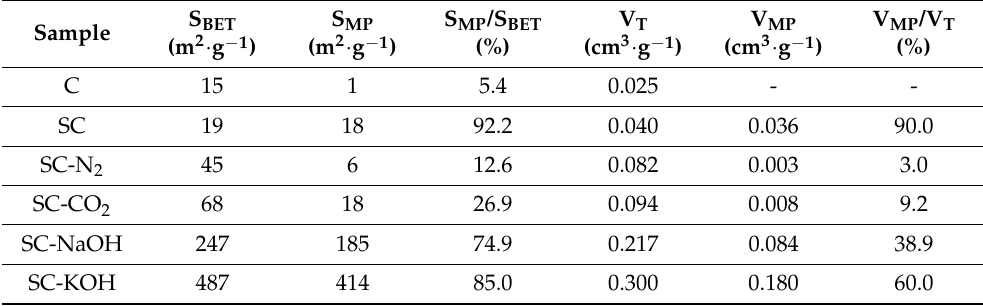
Table 1. Textural properties of the char from plastic pyrolysis before and after